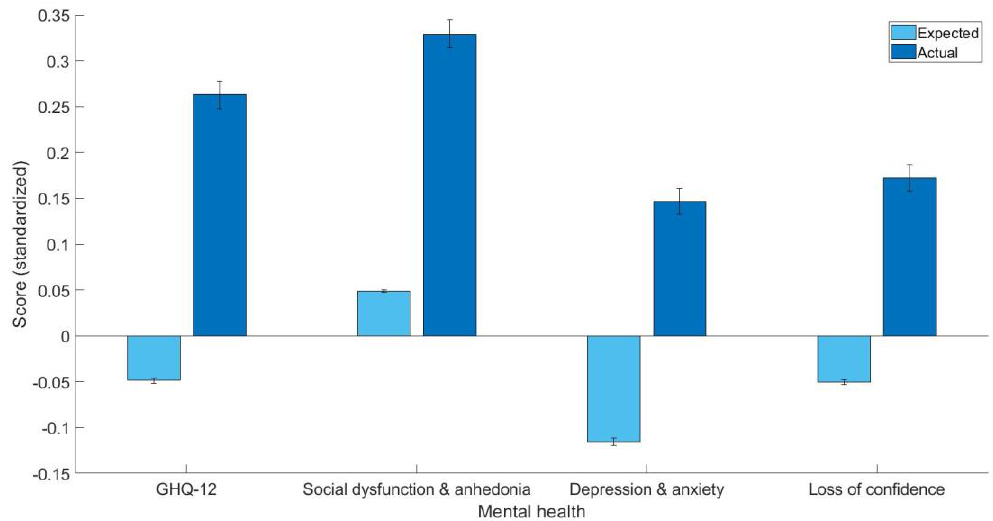
Figure 1. The expected and actual scores (standardized) for GHQ-12 summary score, GHQ-12A (so-